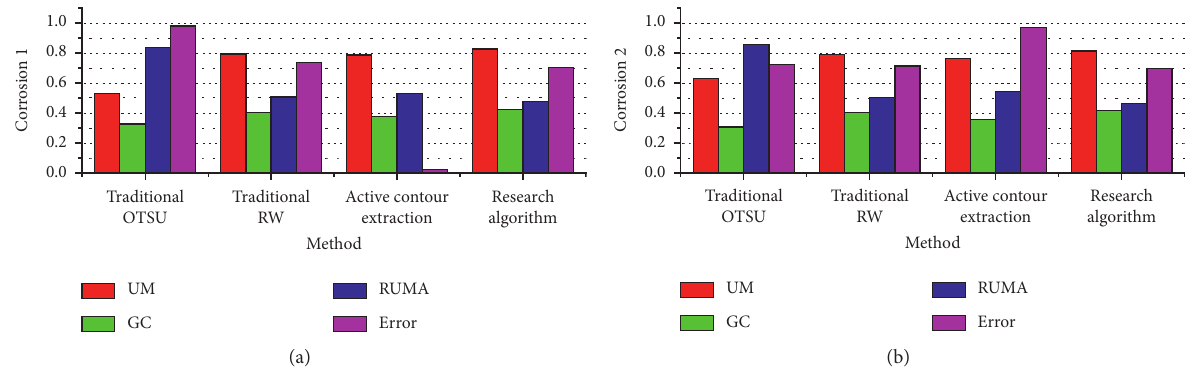
Figure 5: Algorithm performance evaluation results.